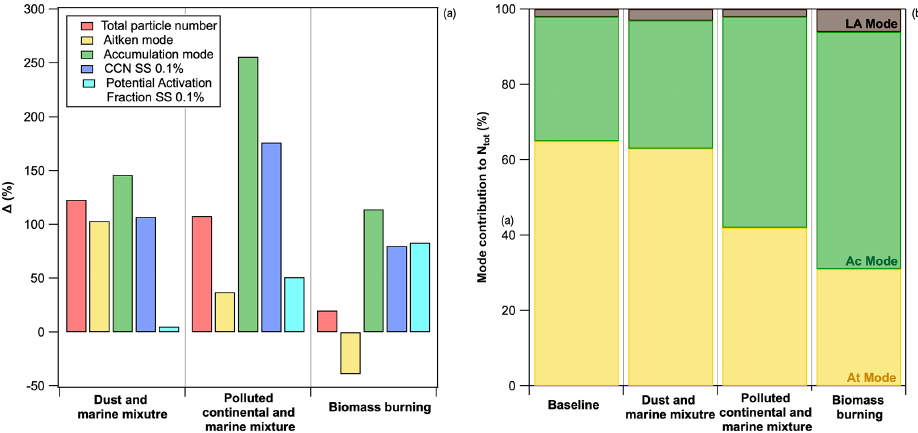
Figure 8. Mean percentage change in N tot , N At , N Ac , N CCN,0.1% , and CCN potential activation fraction at SS 0.1% for each type of event (a) ; Aitken, accumulation and large accumulation particle modes relative contribution to N tot , for baseline and each type of event (b)